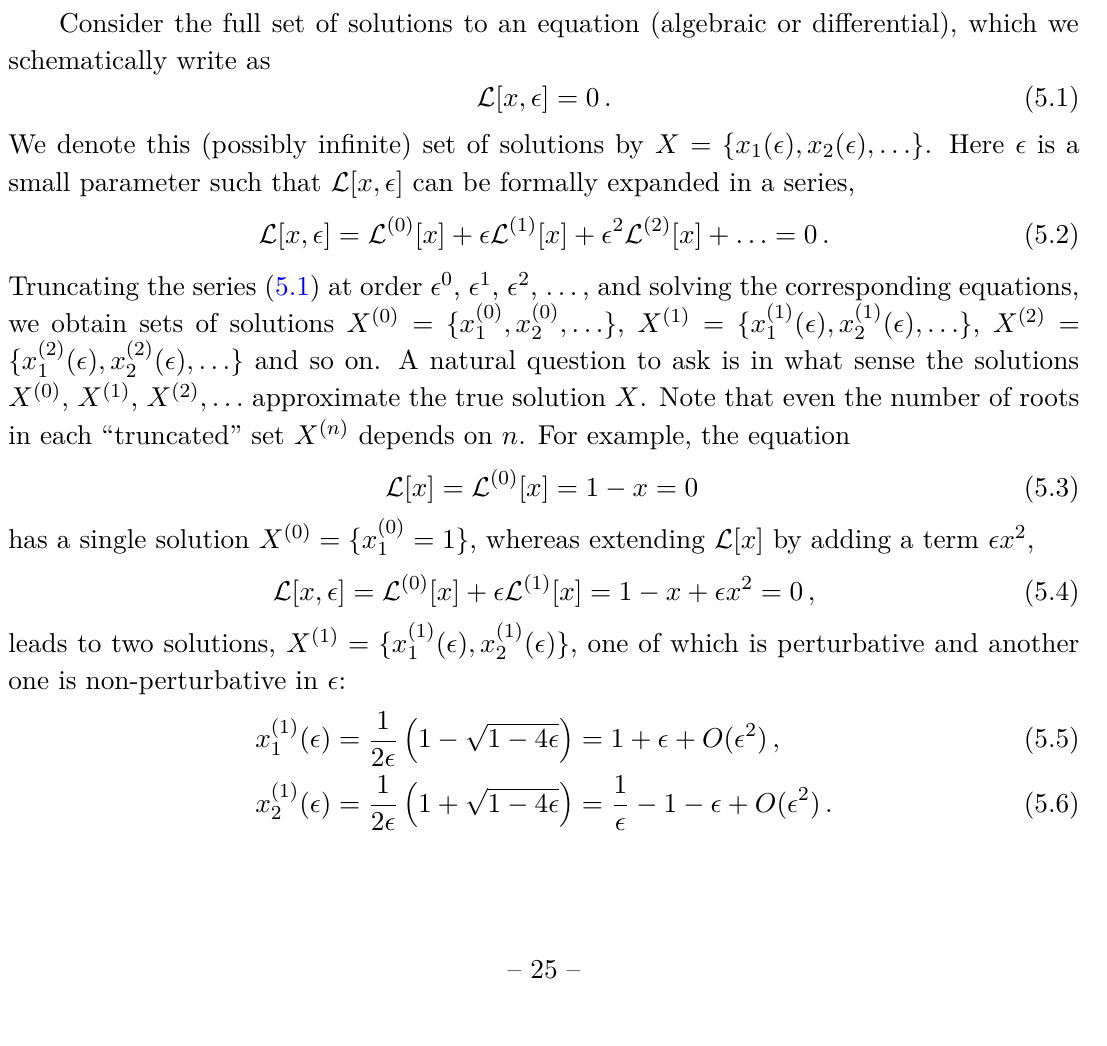
( λ < 0 ). The blue GB GB ≈ − 0 . 0338 GB